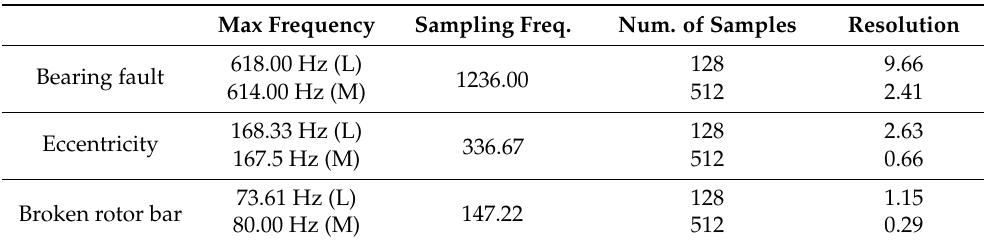
Table 5. Resolution frequency for each type of fault using the Arduino Uno or the Arduino Mega for the lathe (L) and milling machine (M).